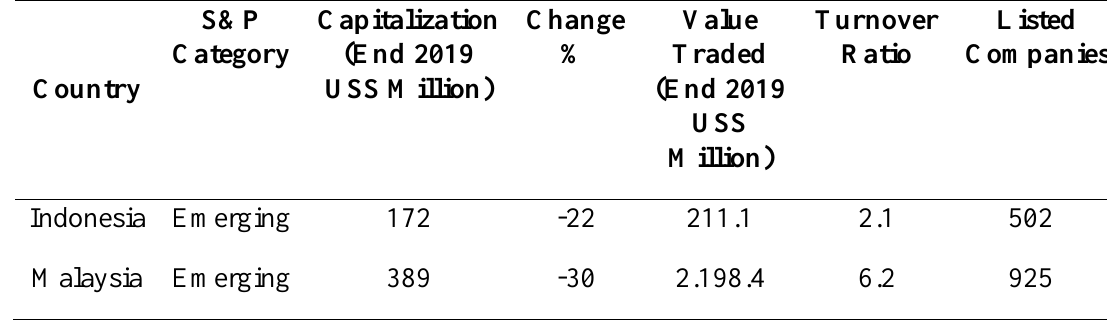
Table 1. Characteristics of Indonesia and Malaysia Shariah Stock Market